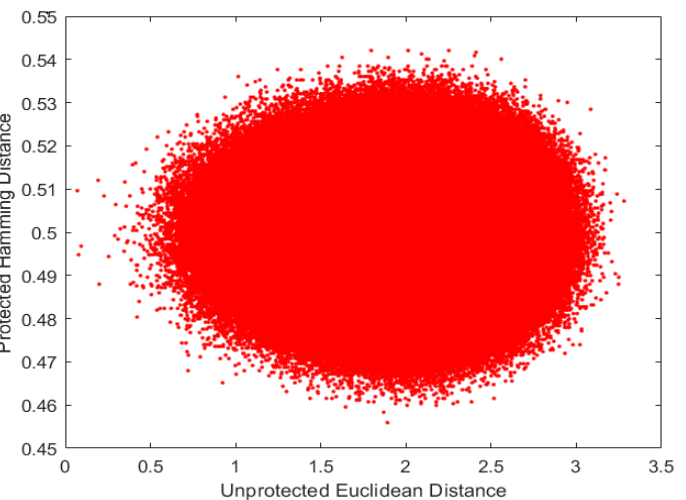
Figure 7. Evaluation of the resistance to similarity ‐ based attacks for the LFW database with Classic McEliece mceliece6688128 parameter set. McEliece mceliece6688128 parameter set.